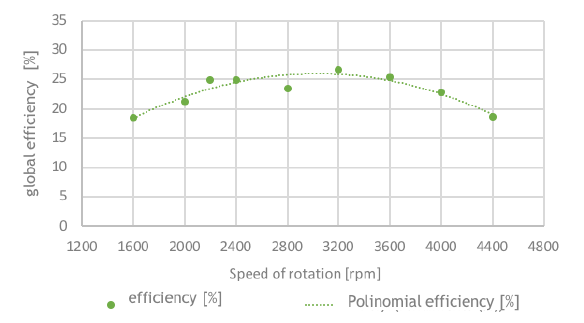
Figure 7: Overall engine performance curve.